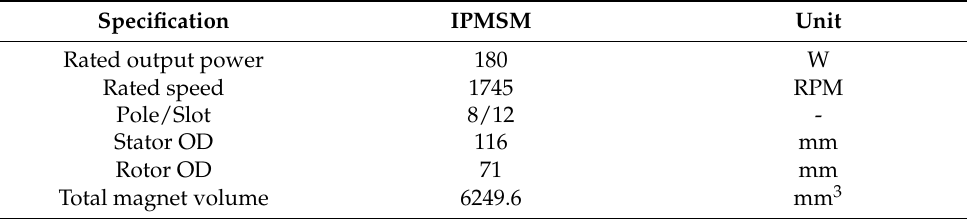
Table 1. Specification of analysis